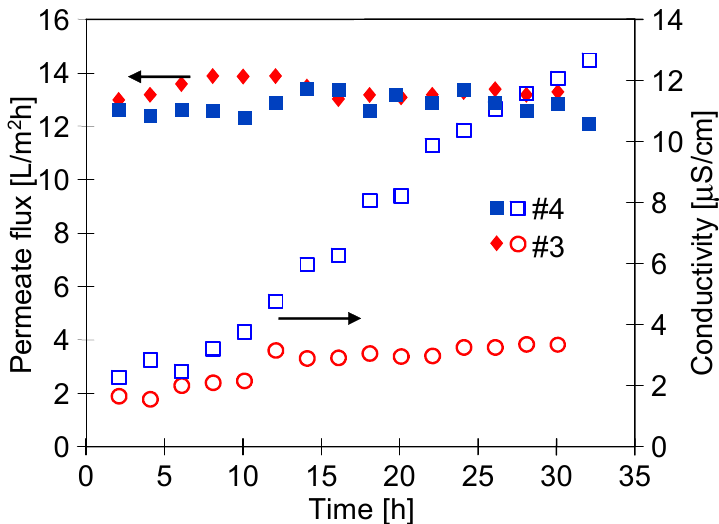
Figure 20. Oil concentration in the obtained distillate.